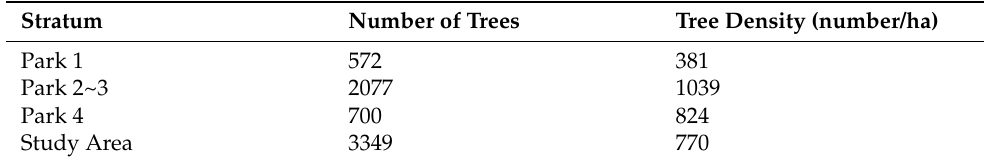
Table 1. Population summary by stratum per unit area.